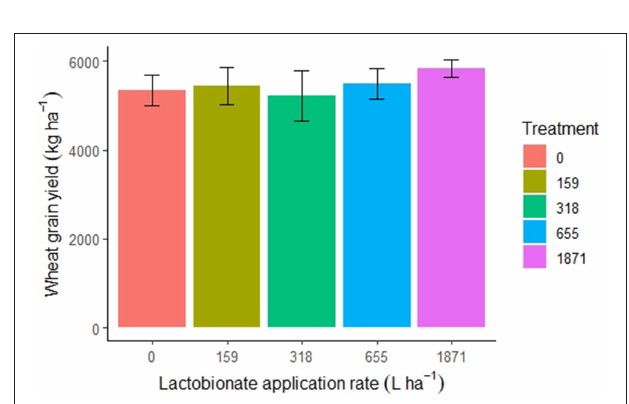
FIGURE 4 | Effect of lactobionate application on wheat grain